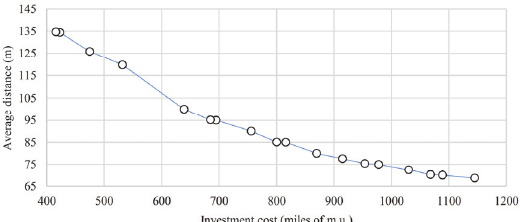
Fig. 4. Pareto front of the second scenario. Number of grid points = 20. Multi-objective approach = AUGMECON2